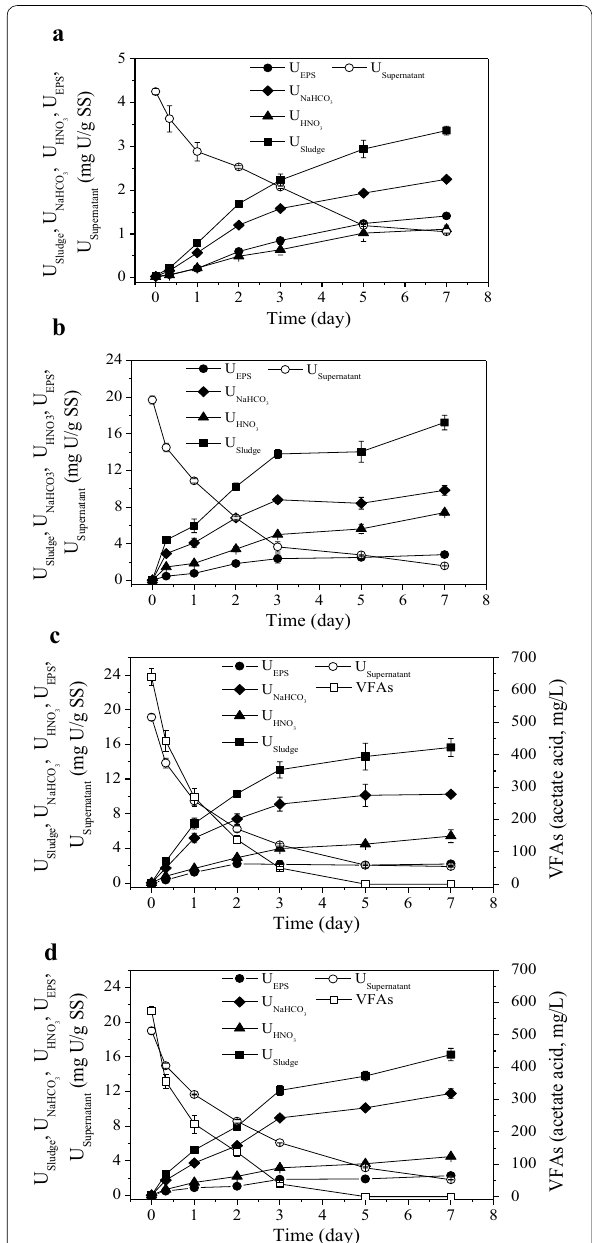
Fig. 2 Profiles of: VFAs, U Supernatant , U EPS , U NaHCO 3 , U HNO 3 and U Sludge in the time course of U(VI) immobilization by anaerobic sludge. a Test 1, 10 mg/L U(VI) without acetate; b test 2, 50 mg/L U(VI) without acetate; c test 3, 50 mg/L U(VI) with acetate; d test 4, 50 mg/L U(VI)